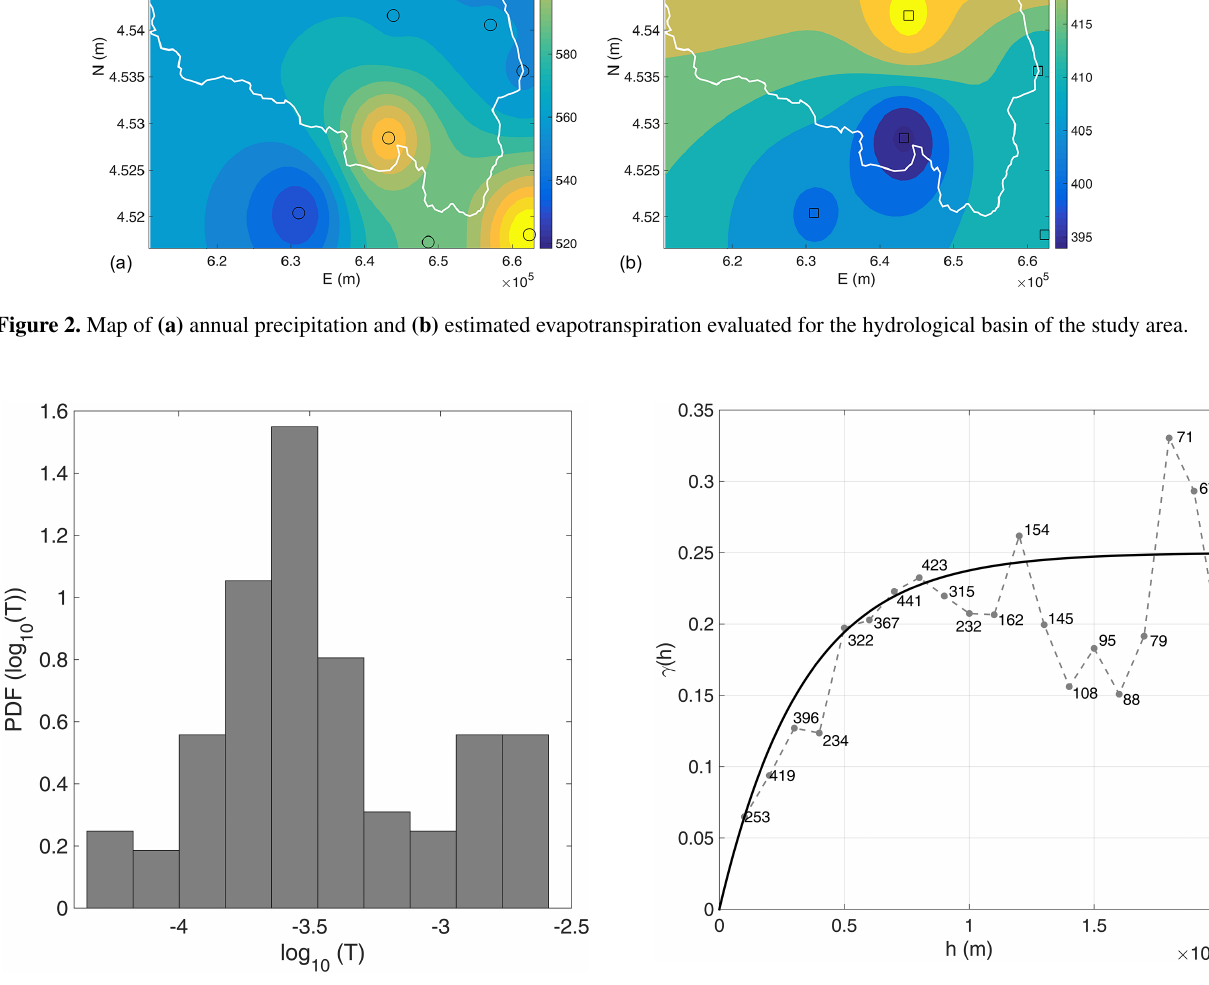
Figure 3. Statistical distribution of log 10 ( T ).